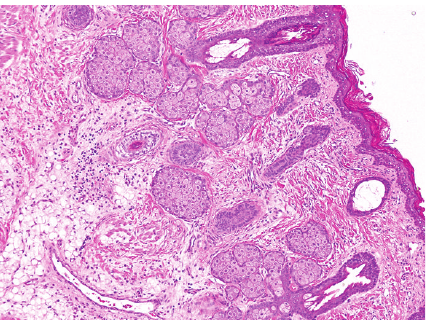
Figure 3: Photomicrograph of the lesion shows a lining of keratiniz- ing stratified squamous epithelium with underlying pilosebaceous units embedded in fibrous tissue. The deeper portion of the lesion shows fibroadipose tissue and focal groups of skeletal muscle fibers (hematoxylin and eosin, 100x